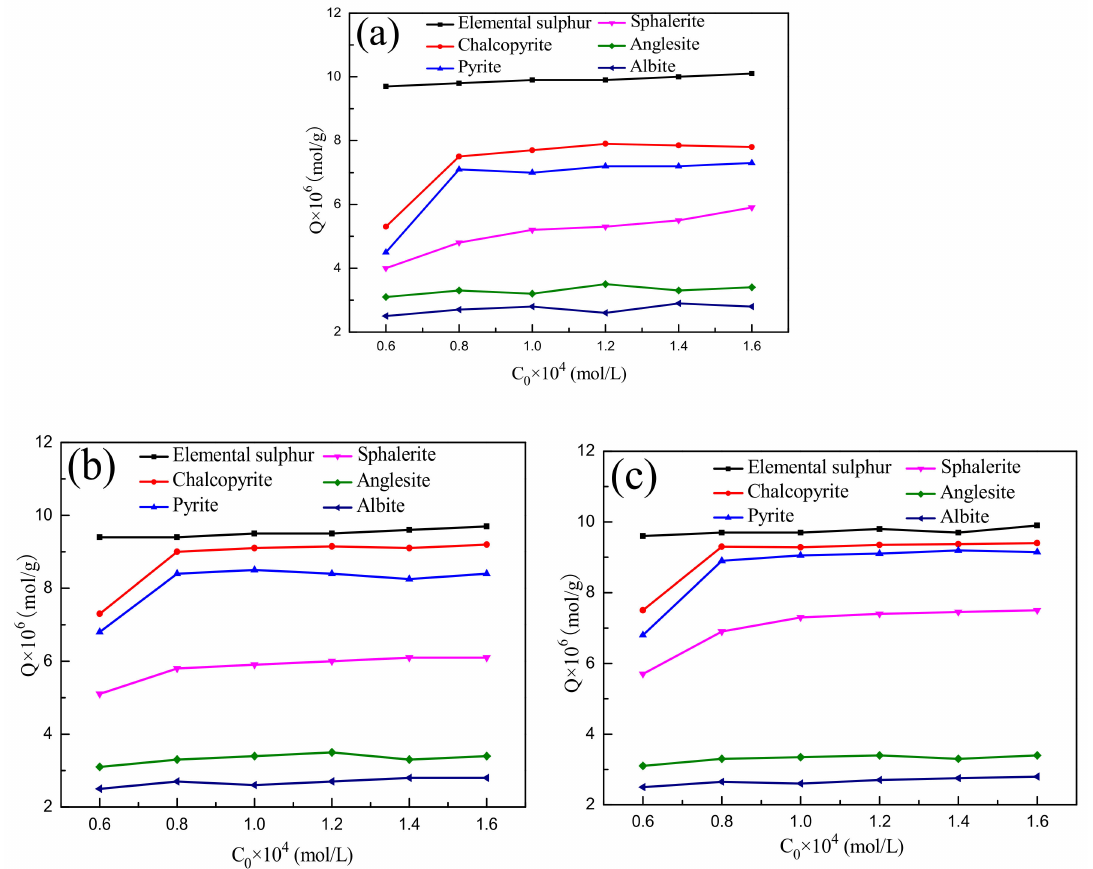
Figure 5. Effect of initial collector concentration on their adsorption amounts on pure mineral surfaces at pulp pH 8 (( a ) IPETC; ( b ) ADDTP; ( c )